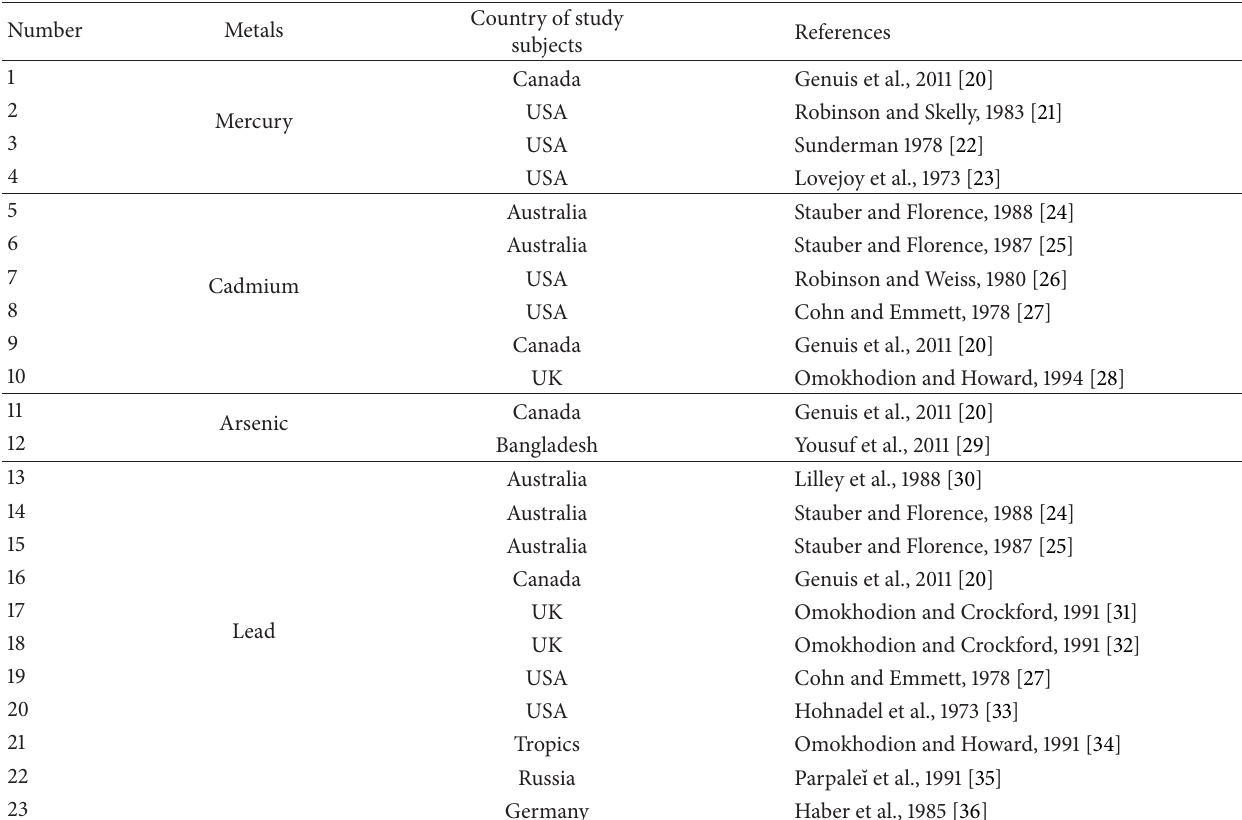
Table 2: Studies of metal excretion in